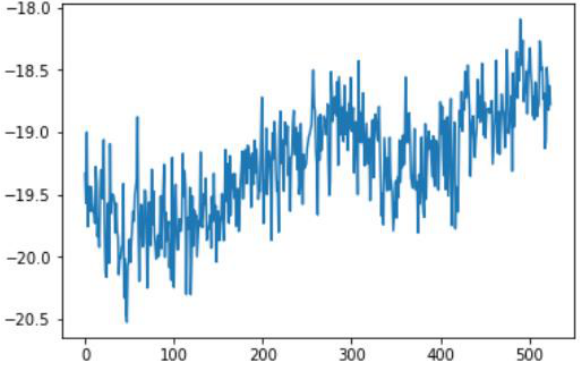
Figure 61. Continuous change in magnetic y -axis data.